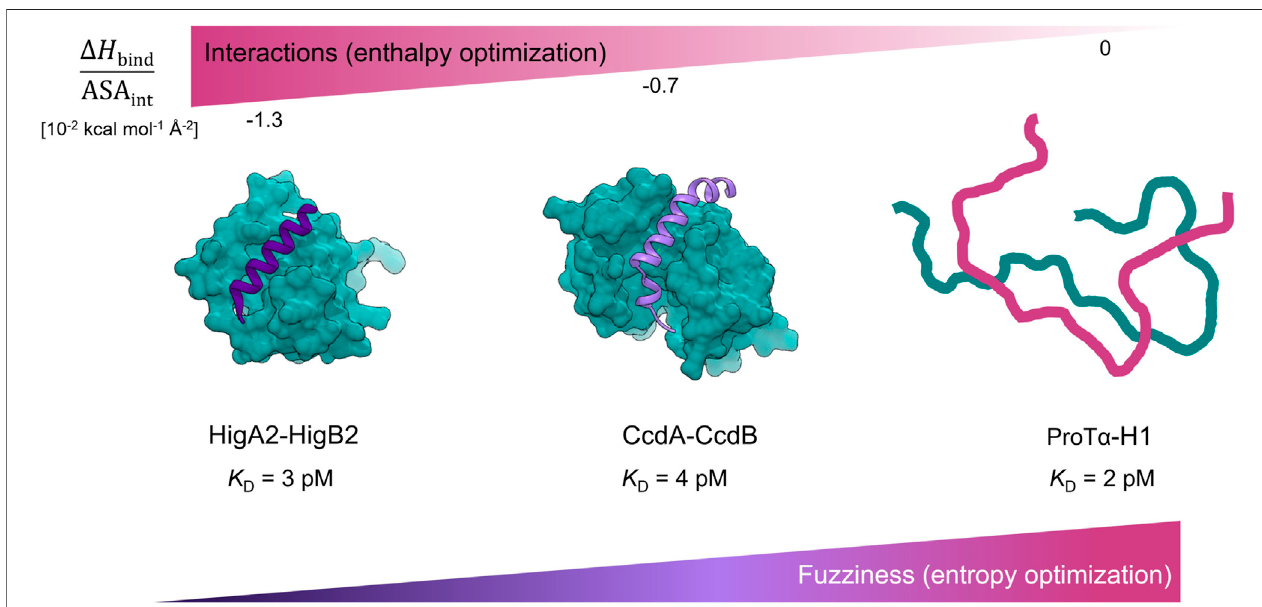
FIGURE4| Ultra-highaf fi nityassociationofIDPsreachingpicomolaraf fi nitiesemploydifferentthermodynamicstrategies.Complexesareorderedaccordingtothe degree of energy optimization as estimated by the Δ H bind /ASA int values. For the HigA2 3-23 -HigB2 complex the degree of energy optimization is similar to one observed for the pairs of globular high af fi nity binders ( Supplementary Table S1 , Figure 3A ). The CcdA 37-72 -CcdB 2 complex exhibits fuzziness in the bound-state (Had ž i et al., 2017b) and has lower degree of energy optimization ( Supplementary Table S1 , Figure 3A ). The high af fi nity complex between ProT α and histone H1 is highly dynamic and is entropically stabilized (Borgia et al.,